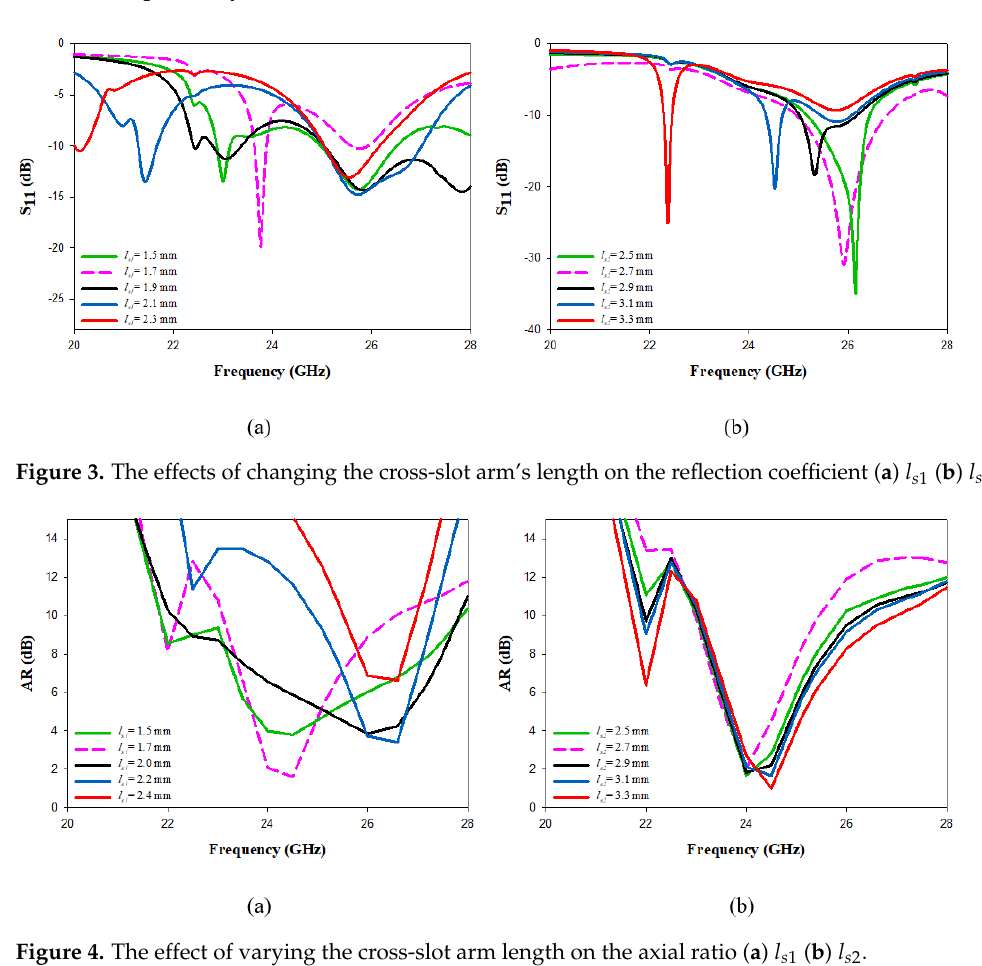
Figure 4. The effect of varying the cross-slot arm length on the axial ratio ( a ) l s 1 ( b ) l s 2